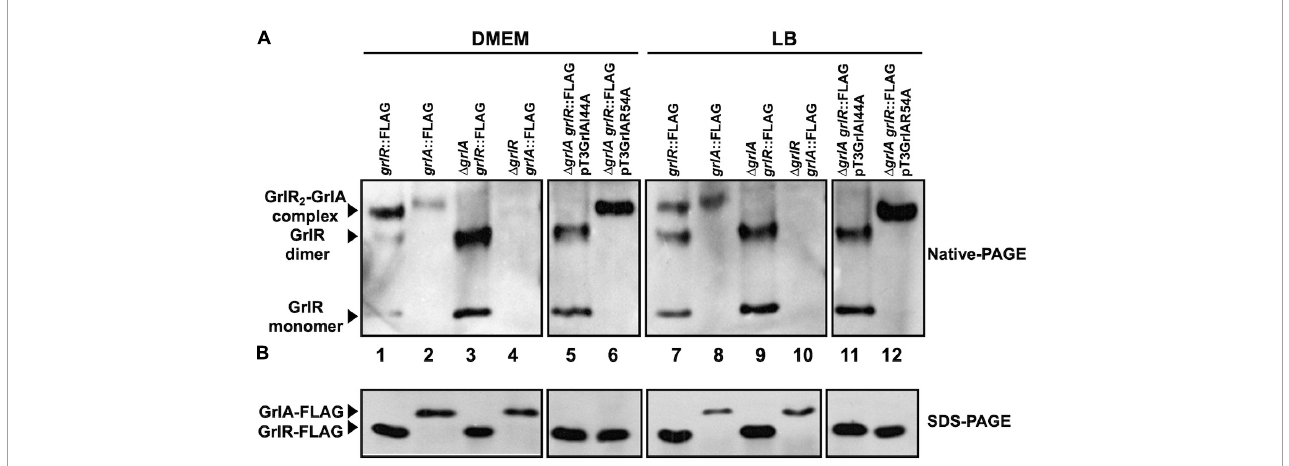
FIGURE7 Analysis of GrlR 2 -GrlA complex formation by native gel electrophoresis. (A) GrlR 2 -GrlA protein complex formation in the enteropathogenic Escherichia coli (EPEC) strains grlR :3xFLAG, grlA :3xFLAG, (cid:49) grlR_grlA :3xFLAG, grlR :3xFLAG_ (cid:49) grlA, as well as in the grlR :3xFLAG_ (cid:49) grlA strain carrying plasmids pTEPGrlA1/I44A or pTEPGrlA1/R54A, was analyzed from samples taken from cultures grown in Dulbecco’s modified Eagle’s medium (DMEM) or Lysogeny Broth (LB) at an OD 600 of 1. Total extracts were obtained from bacterial pellets and separated by 12% native PAGE. The GrlR 2 -GrlA and GrlR-GrlR complexes and the GrlR monomer (indicated by arrows) were identified by western blotting using anti-FLAG monoclonal antibodies. (B) The same cell extracts were also separated by 12% SDS-PAGE and transferred to a PVDF membrane for western blotting to confirm GrlR-3xFLAG and GrlA-3xFLAG expression in the different strains using anti-FLAG